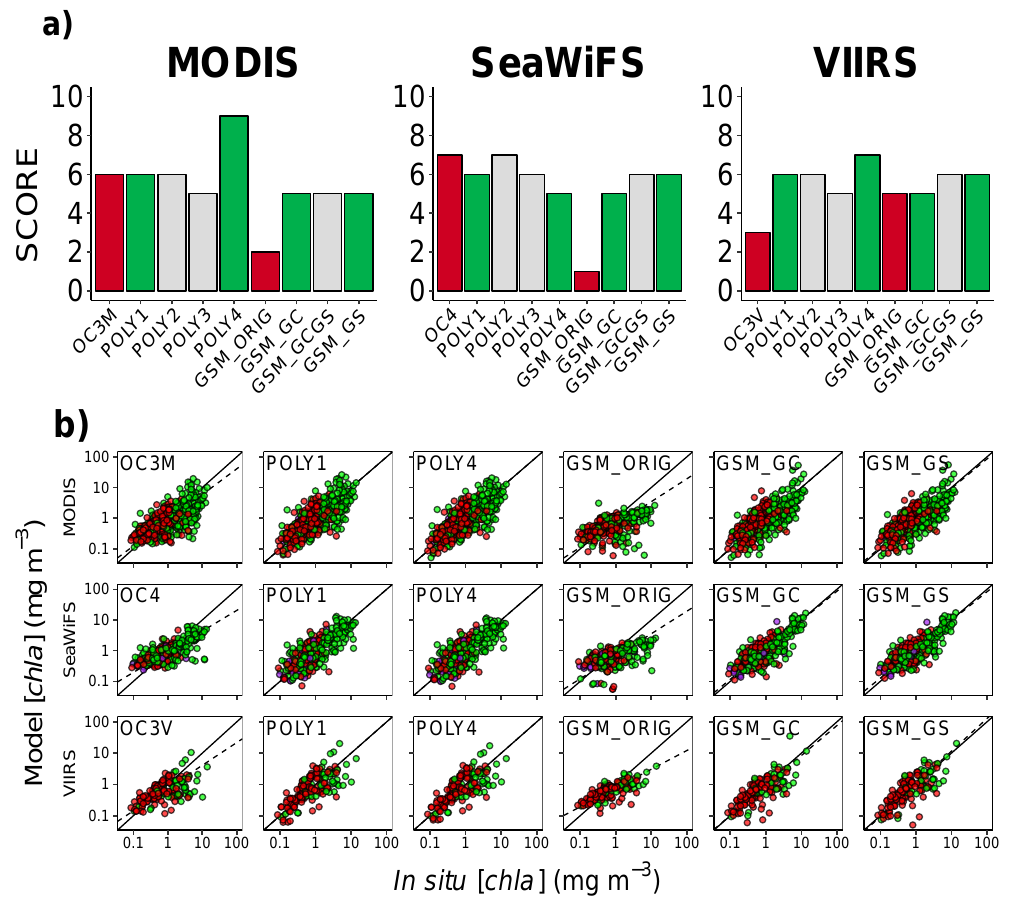
Figure 4. ( a ) Algorithms’ scores for Moderate Resolution Imaging Spectrometer (MODIS), Sea-viewing Wide Field-of-view Sensor (SeaWiFS) and Visible Infrared Imaging Radiometer Suite (VIIRS) in the NWA based on the mean log-transformed error ( MLE ), mean magnitude of log-transformed error ( MMLE ), and r 2 from the linear regression of satellite-derived on in situ chla , the percentage of retrievals, and the win ratio metric. Red bars correspond to the original algorithms, green bars correspond to regionally-tuned algorithms discussed in the text, grey bars corresponds to regionally-tuned algorithms presented only in Tables A1 and A2 of Appendix A. ( b ) Satellite-derived versus in situ chla , green solid circles correspond to the spring season and red solid circles correspond to the